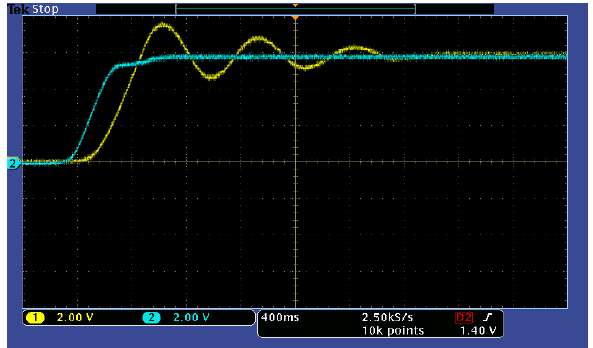
Figure 11. Input (yellow) and output (blue) waveforms, gain=15.